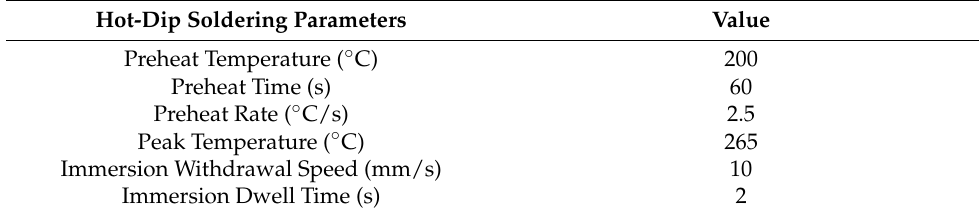
Figure 1. Schematic diagram of the hot-dipping process. Table 2. Solder hot-dipping process parameters.